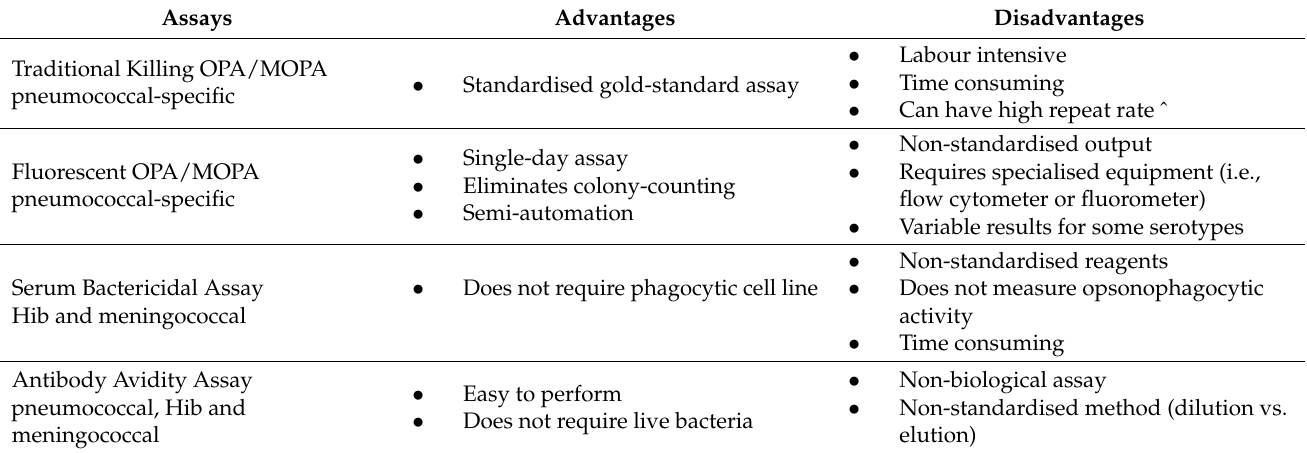
Table 1. Advantages and disadvantages of currently available functional assays.